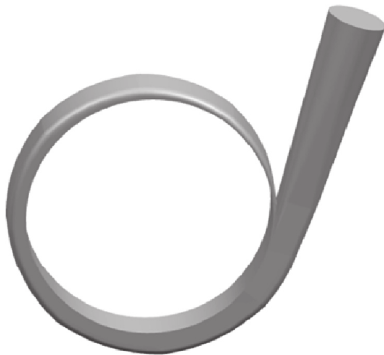
Figure 9: Model of volute.